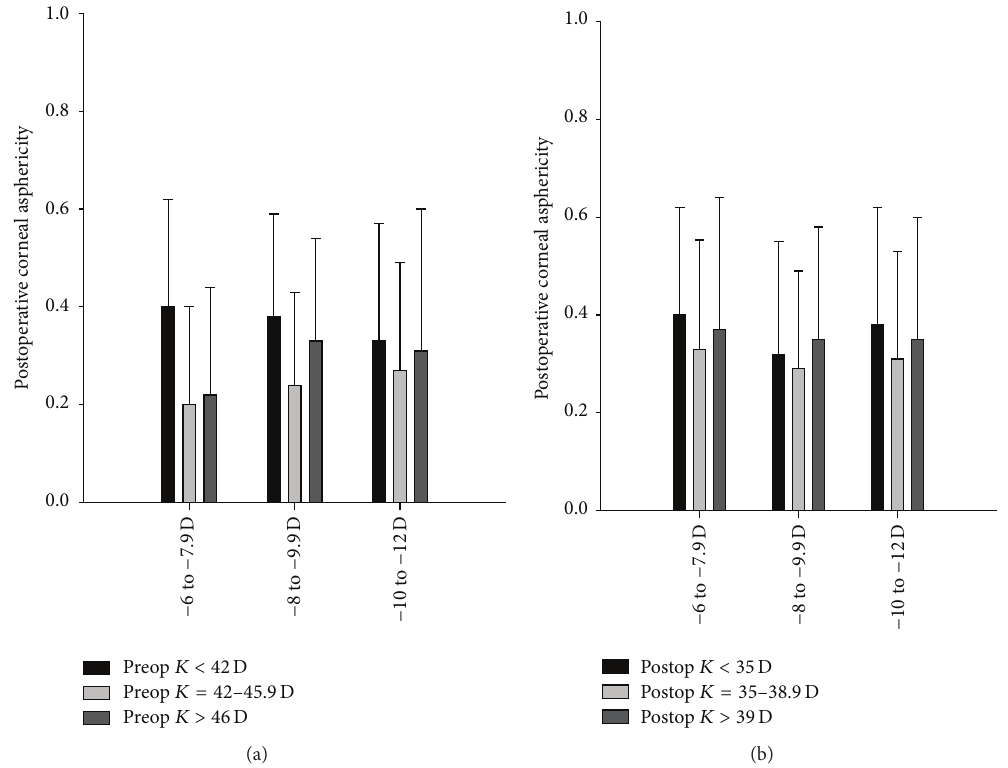
Figure 2: Postoperative corneal asphericity stratified by pre- and postoperative keratometry,